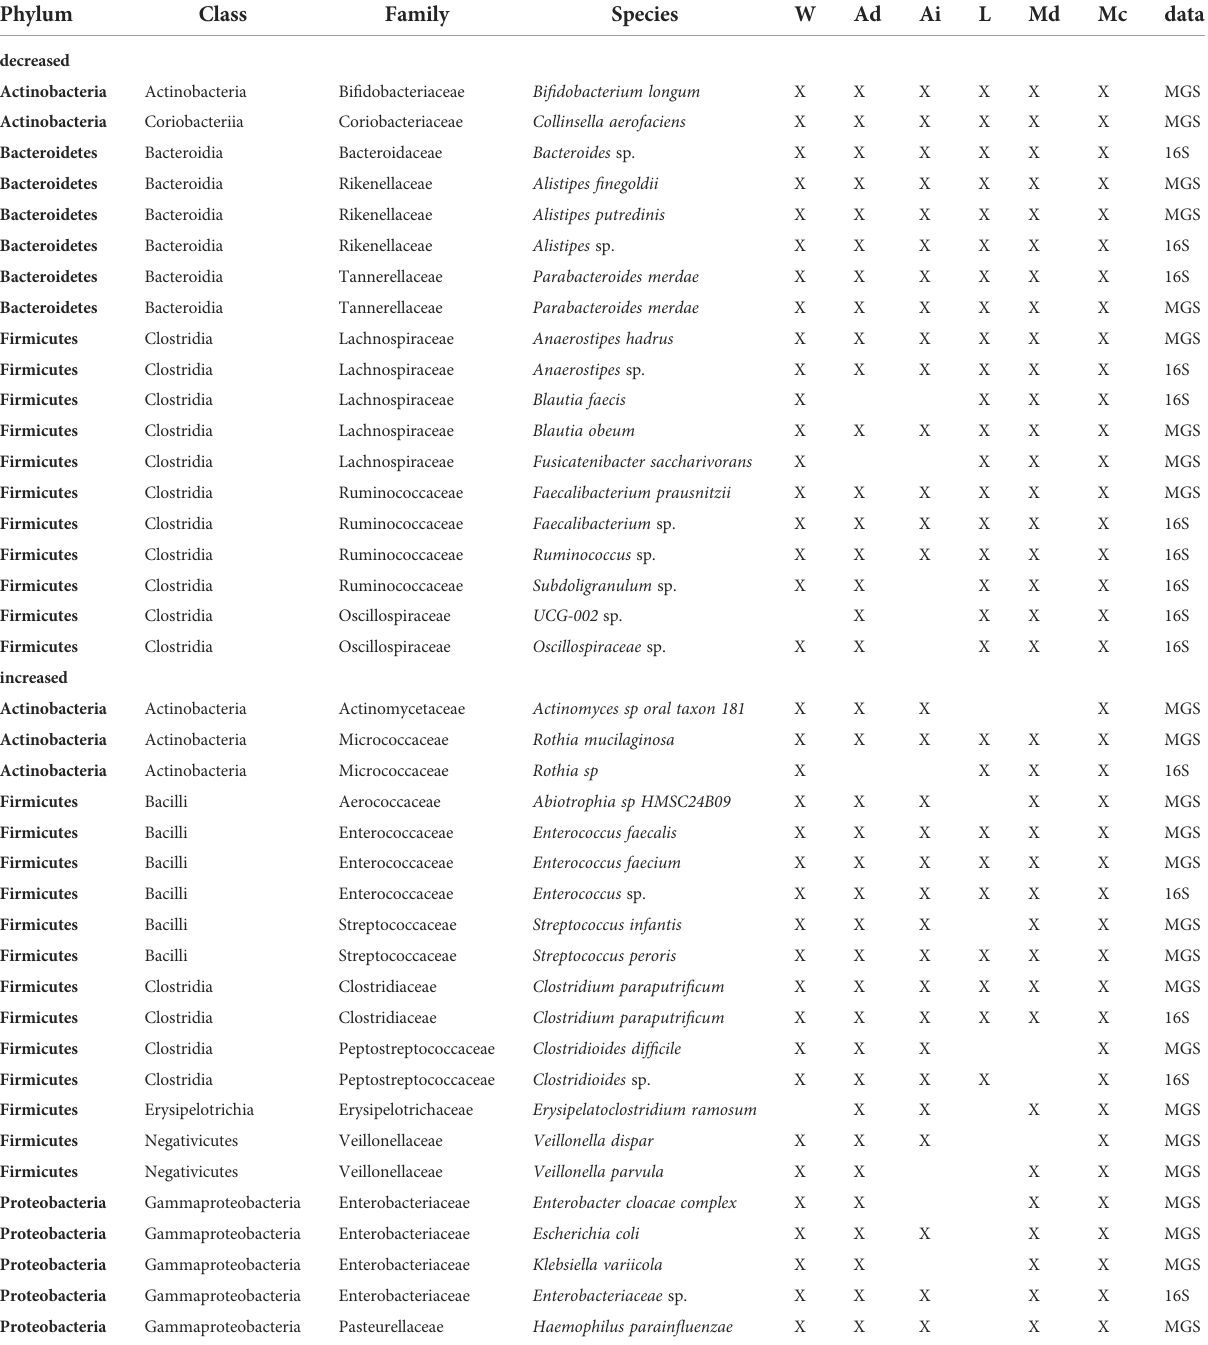
TABLE 6 Taxa identi fi ed by 4 or more different methods as being differentially abundant based on antifungal use in the 15 days before sampling identi fi ed in 16S rDNA and shotgun metagenome sequence data.